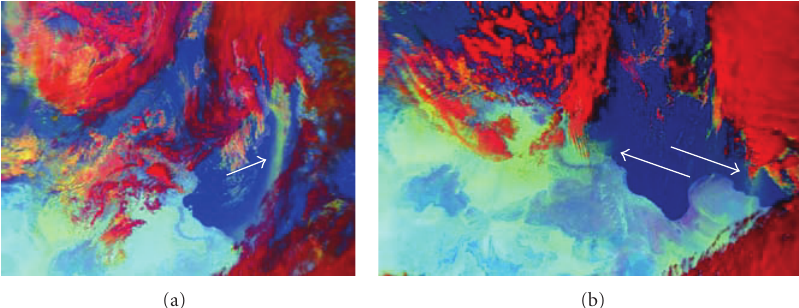
Figure 9: NOAA11 AVHRR satellite visible images received at (a) 12:24 UTC on 26 March and (b) 12:12 UTC on 27 March 1992.